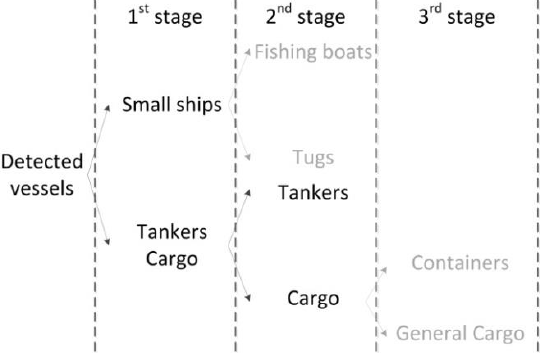
Figure 5. Hierarchical classification scheme, utilizing two distinct classification stages, plus a potential third one.